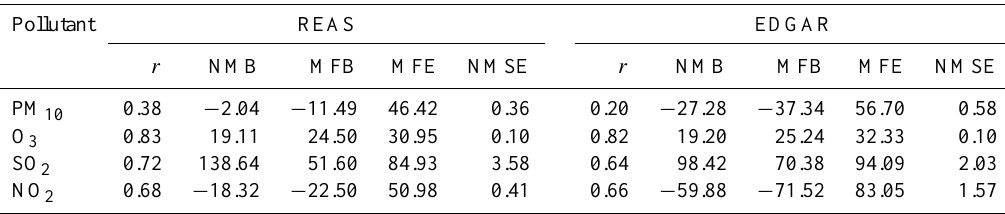
Table 2. Statistical measures calculated for model simulations using REAS and EDGAR as emissions inputs for PM 10 , O 3 , SO 2 , and NO 2 . r is the correlation coefficient between observations and model simulations; NMB (%) is the normalized mean bias between observations and model simulations; MFB (%) and MFE (%) are the mean fractional bias and mean fractional error; NMSE is the normalized mean square error between the observations and model.